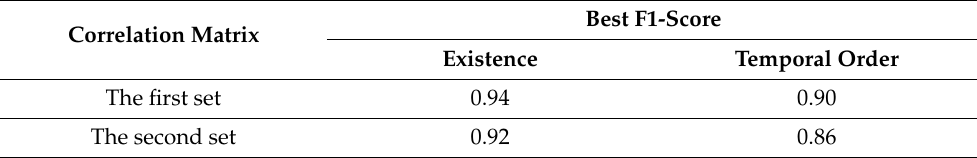
Table 13. Best F1-scores for anomaly detection using two sets of correlation